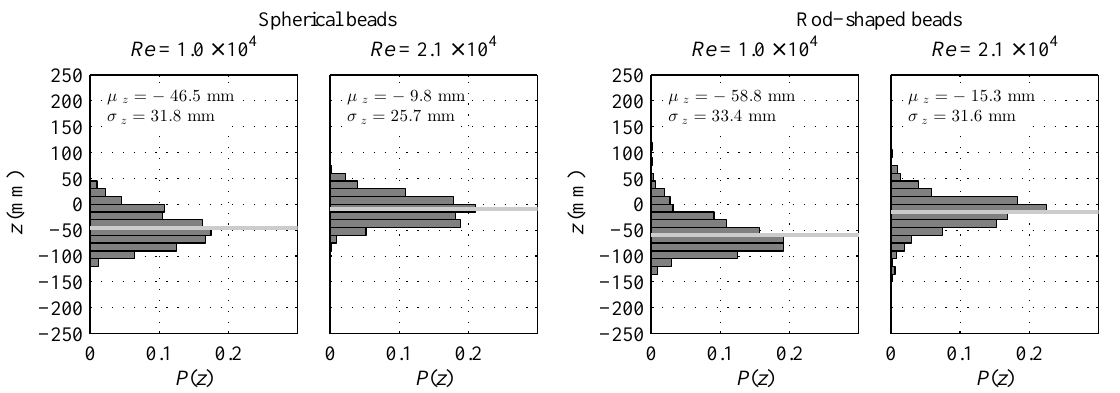
Figure 8. Histograms showing vertical distributions of beads at x = − 2 D for selected tests. The distribution mean is shown with a light grey line for each test. The extent of the y -axis of these plots is equal to the length of the collision objects.